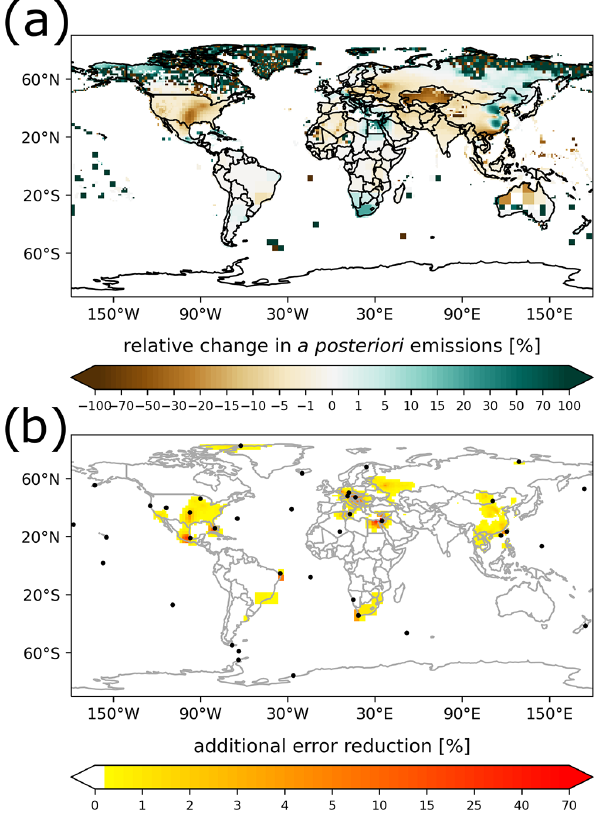
Figure 13. (a) Relative change in a posteriori emissions and (b) the additional error reduction when using flask measurements in addi- tion to continuous measurements for the 50d simulation. The loca- tions of the flask measurements are marked with black